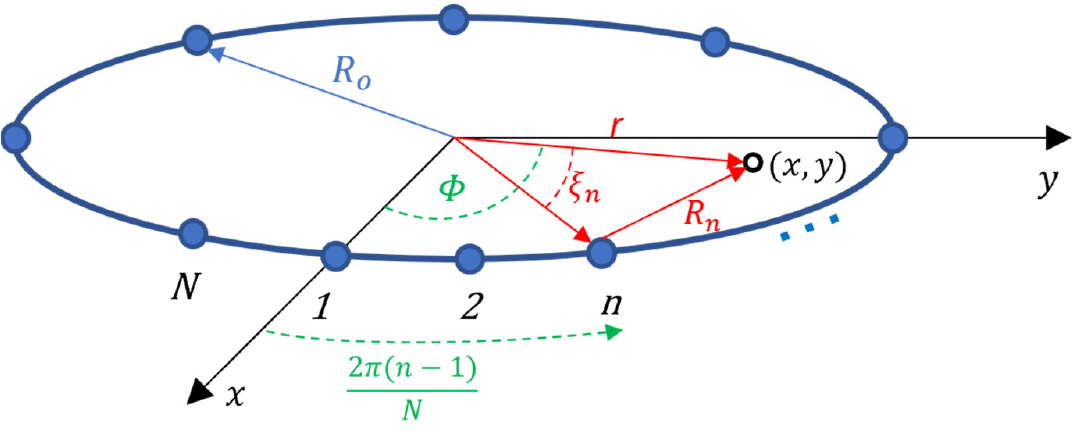
. The point scatterer (cid:3042) , 𝑅 is given by the law of cosine, (cid:3042) (cid:3041)